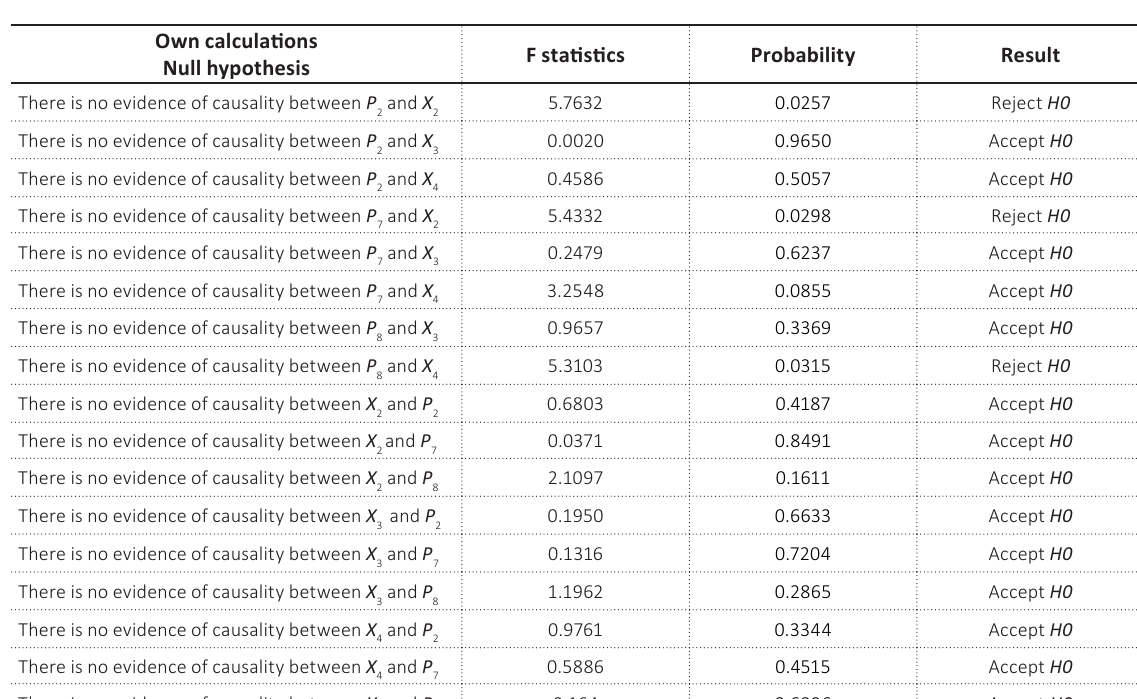
Table 2. Granger causality test – F